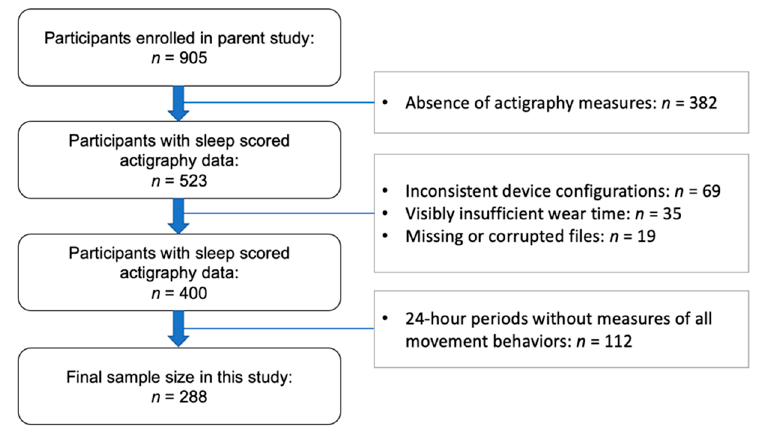
Figure 1. STROBE study flow chart of participants.